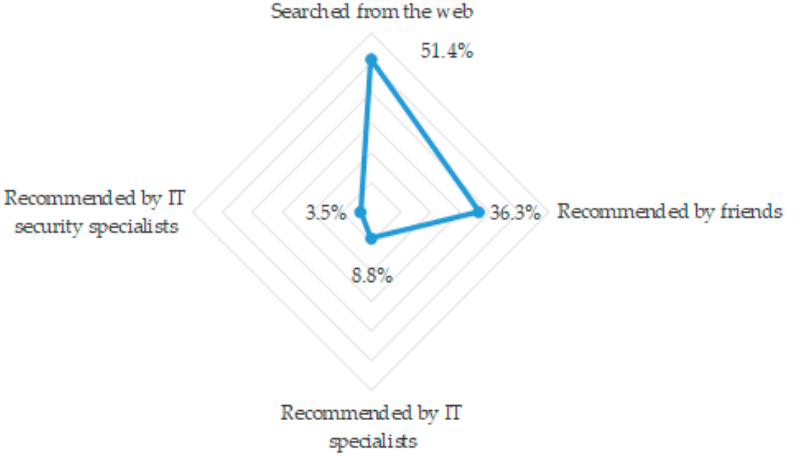
Figure 6. Choice of evaluation tools.